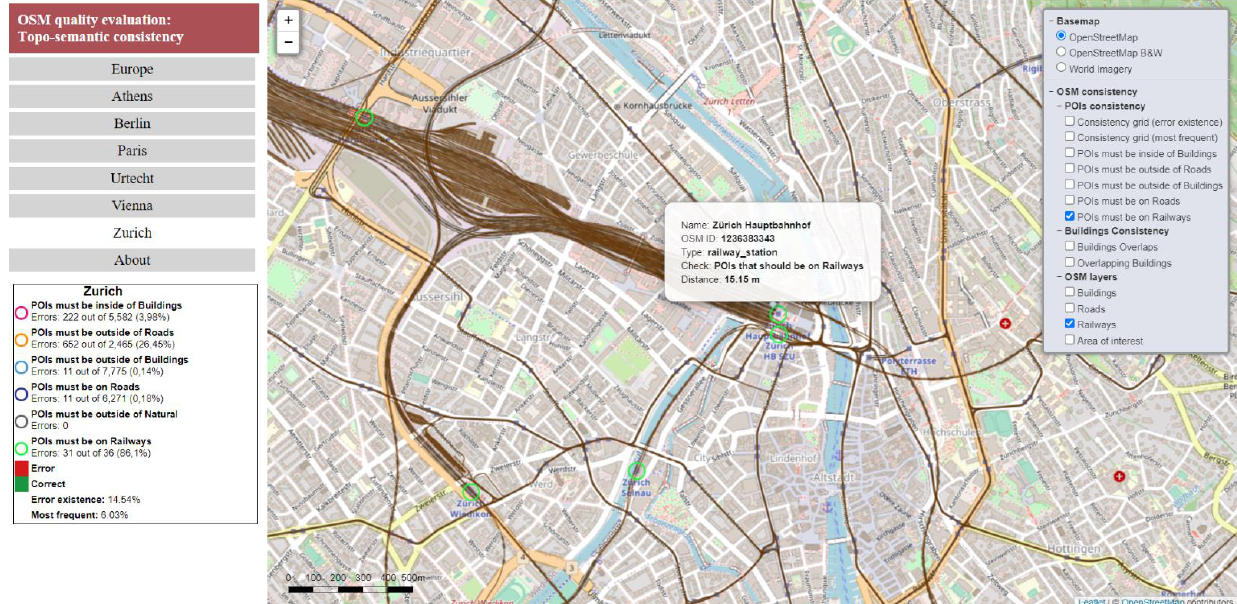
Figure A10. Errors from the topo-semantic consistency check “POIs must be on Railways” for Zurich. The “Railways” layer is portrayed as well. Additional information is provided by clicking on each error.